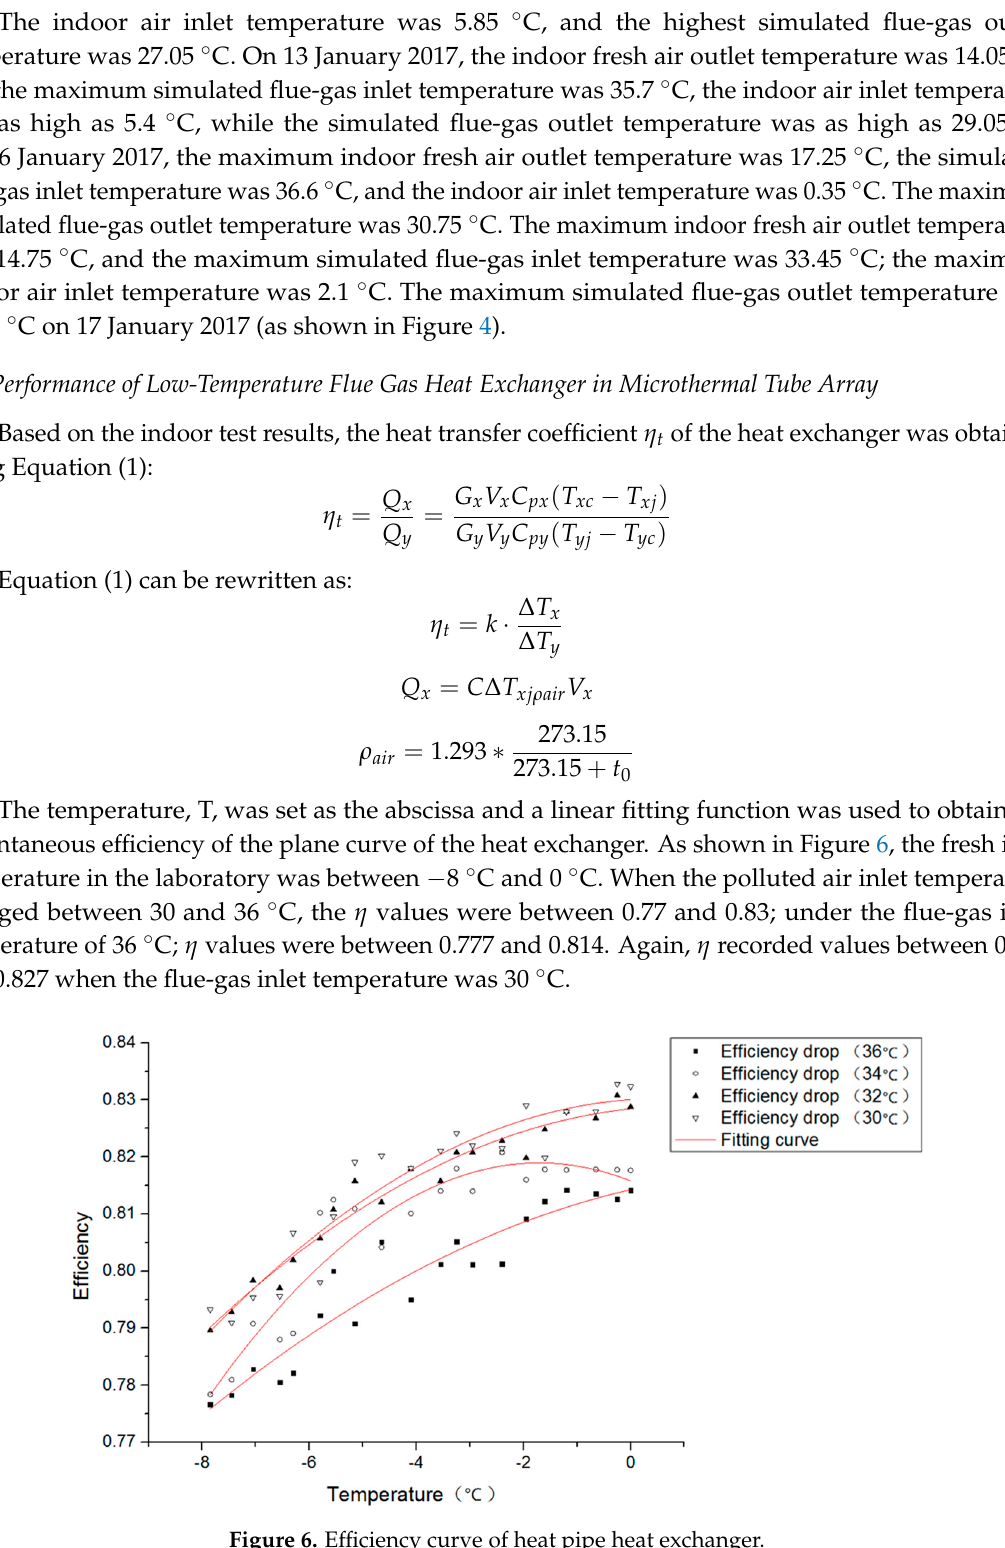
Figure 6. Efficiency curve of heat pipe heat exchanger.